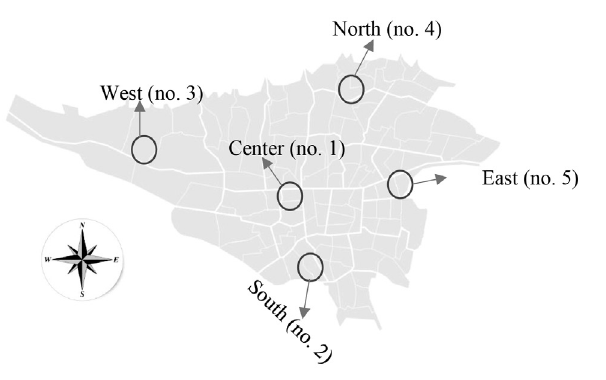
Figure 1. Map of Tehran With 5 Studied